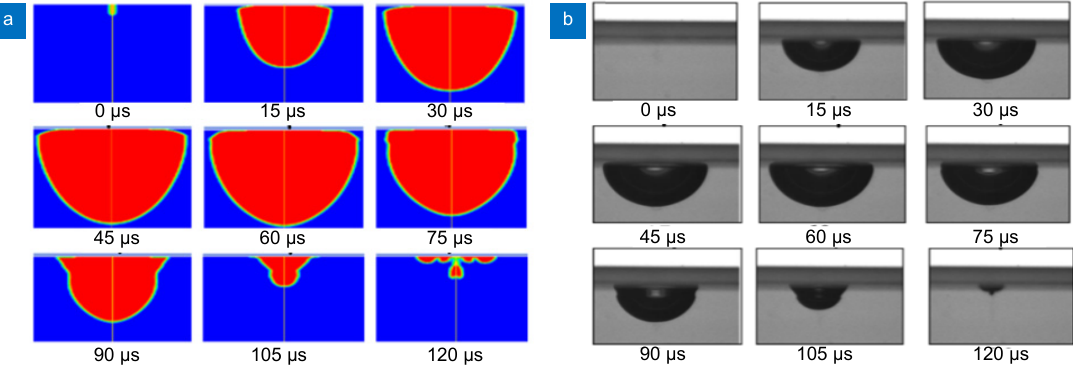
Fig. 7 | (a) Contours of the vapor volume fraction by simulation. (b) High-speed photography of cavitation bubble. Figure reproduced from ref. 64